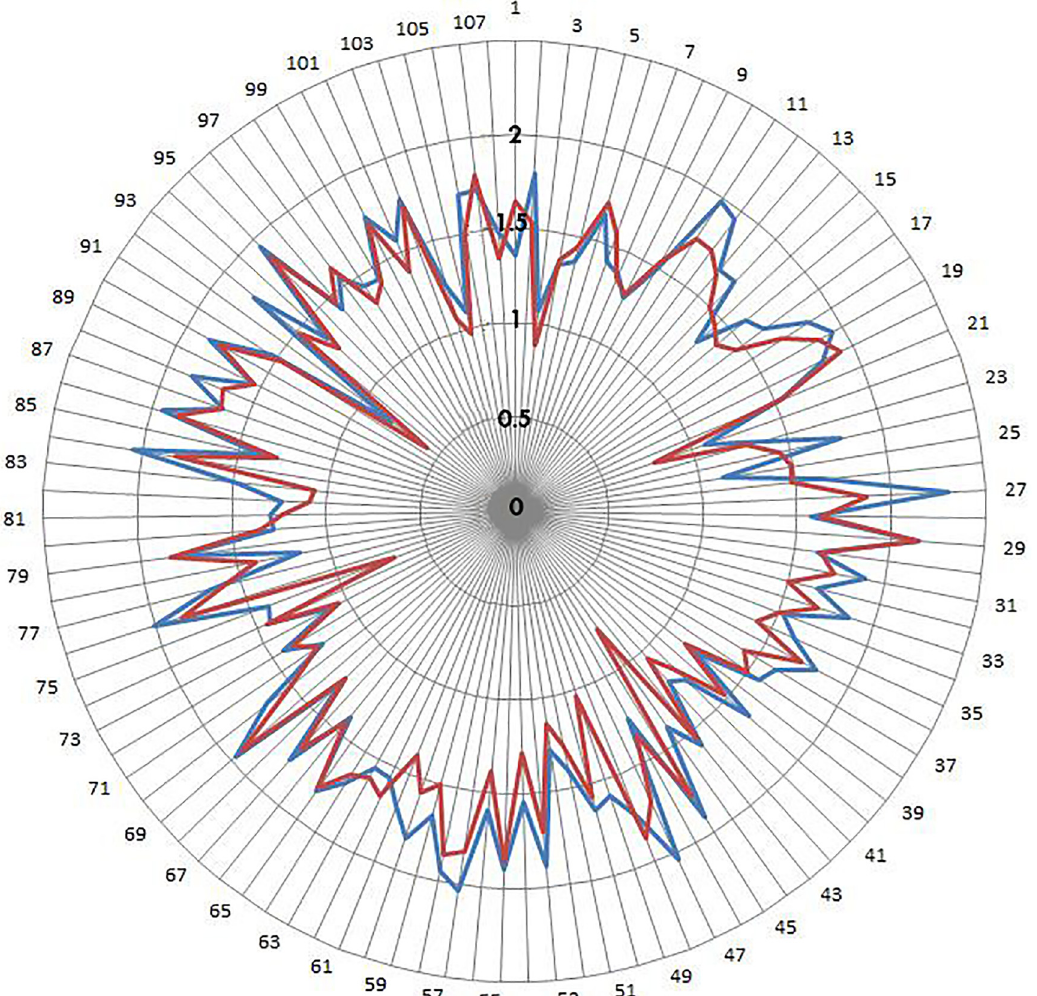
Fig 4. Radar chart for Delphi survey round 2 and round 3 responses. Distribution of the standard deviations for each of the 107 Delphi survey questions (from 1 to 107, in the clockwise direction) in round 2 ( blue line ) and round 3 ( red line ). Note that the distribution of the standard deviations across the 107 survey questions is dampened in round 3 ( red line ) as anticipated in Delphi